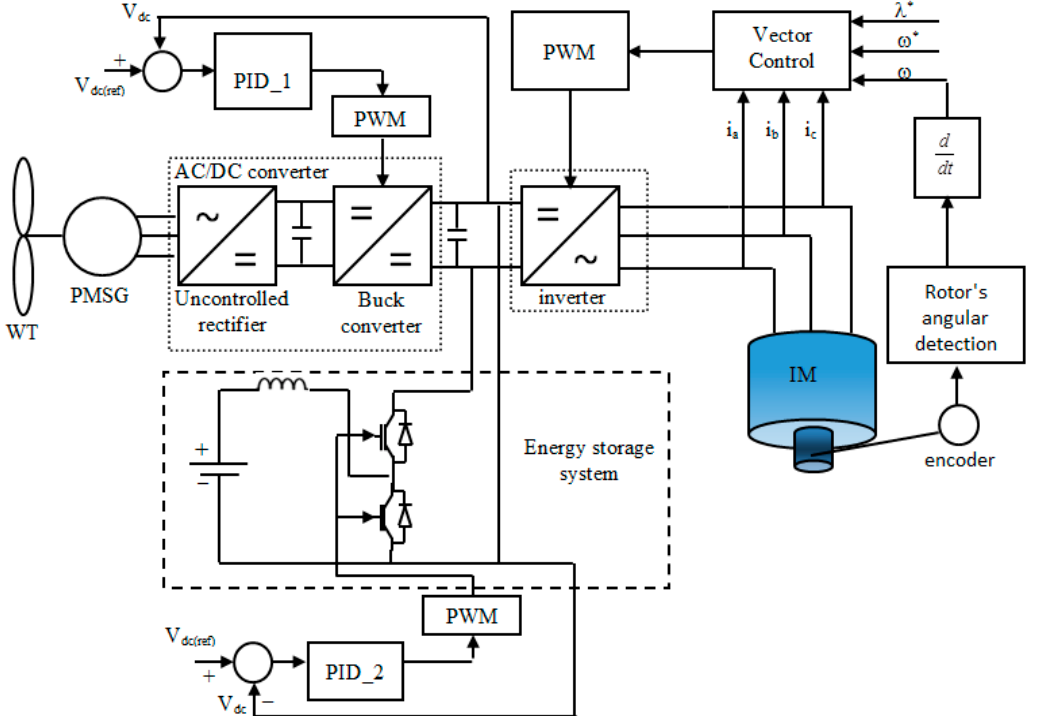
Figure 3. Illustration diagram of autonomous wind/battery storage power transformation component providing IM with suggested control framework.